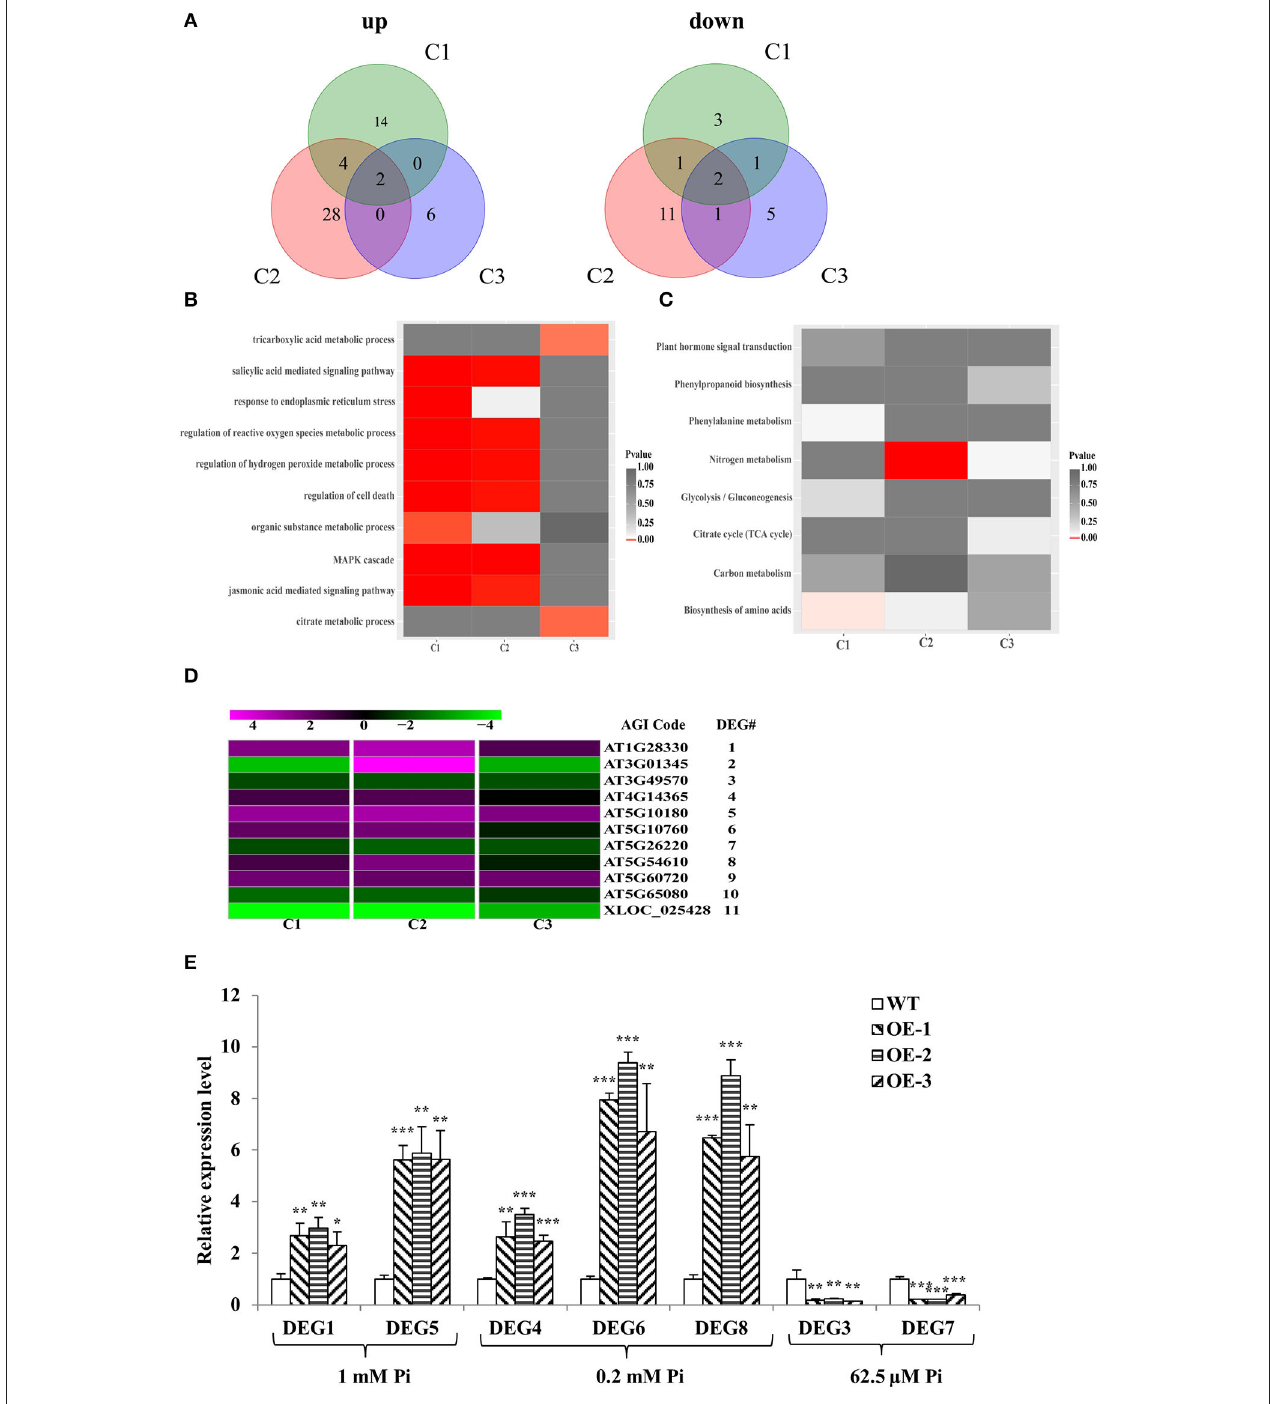
FIGURE 5 | RNA-seq analysis and RT-qPCR verification. (A) Venn diagrams of all genes exhibiting upregulated or downregulated expression between WT and GmWRKY46 -overexpressing Arabidopsis plants. C1, C2, and C3 represent different levels of Pi. (B,C) Results of the GO enrichment analysis (B) and KEGG pathway enrichment analysis (C) of the DEGs between WT and GmWRKY46 -overexpressing Arabidopsis plants. (D) Heat map of clustering analysis of the 11 DEGs in the intersection of C1, C2, or C3. Expression ratios are shown as log 2 values. Magenta represented increased expression; green represented decreased expression; black represented no difference in expression compared with control. (E) Expression patterns of 7 DEGs candidates. Vertical axis showed fold enrichment of relative transcript levels between transgenic and WT plants. Expression was normalized to that of Actin2/8. Data were means ± SD ( n = 3). Data significantly different from the WT were indicated (Student’s t -test, * P < 0.05, ** P < 0.01, *** P <